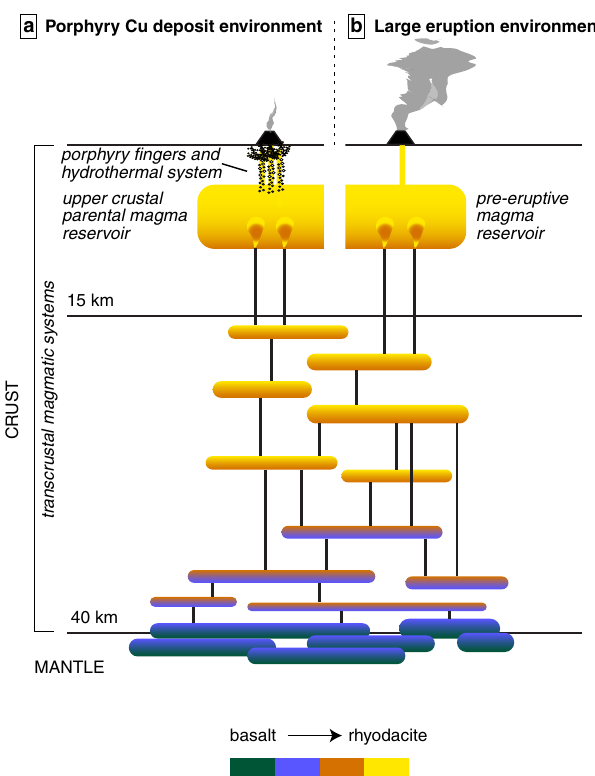
Fig. 1 Transcrustal magmatic systems associated with porphyry copper deposits and with large eruptions. a Transcrustal magmatic systems associated with porphyry copper deposits. b Transcrustal magmatic systems associated with large eruptions. The sketch highlights the similarities between the two systems and is inspired from sketches of previous works 17,33,35,64,69 . The ~40 km depth is indicative and used for consistency with the model which is run for a maximum pressure of 1.2